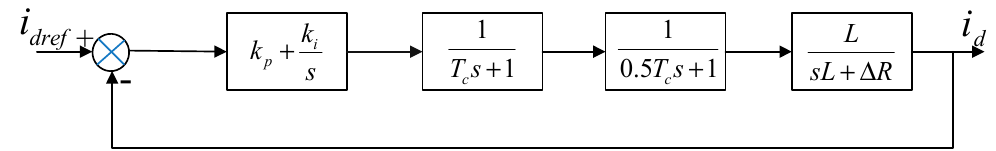
Figure 5. Dynamic block diagram of the current loop considering resistance disturbance and system delay.